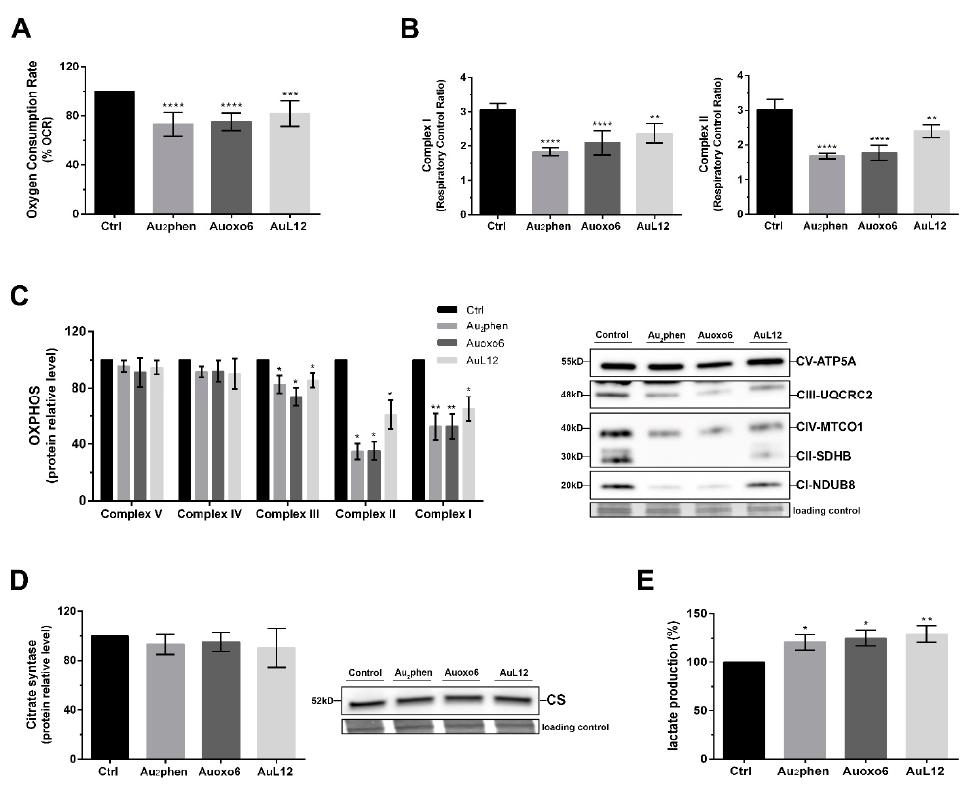
Figure 5. Influence of gold(III) complexes on mitochondrial metabolism. A2780 cells were treated for 24 h with Au 2 phen, Auoxo6, and AuL12 72 h IC 50 doses: ( A ) The percentage of oxygen consumption rate (OCR) and ( B ) the respiratory control ratio (RCR) values were measured using a Clark-type O 2 electrode from Hansatech Instruments (King’s Lynn, Norfolk, UK) as described in Materials and Methods. The protein amount of ( C ) oxidative phosphorylation (OXPHOS) complexes and ( D ) citrate synthase (CS) was evaluated using Western blot analysis. Histograms report the normalized mean relative integrated density (± SD) values for each OXPHOS complex, and CS immune-stained bands compared to controls. Representative immunoblots are also shown together with the matching Coomassie-stained PVDF membranes, which were used as loading control. Original Western blot images of OXPHOS and CS content are reported in Figure S4 and S5. ( E ) The lactate amounts were detected in 1 mL of supernatant medium using a commercial L-lactic acid assay kit (Megazyme, Bray, Ireland). Histograms report the percentages of mean values ±SD with respect to controls. All experiments were performed in triplicate. The statistical analysis was carried out using one-way ANOVA test followed by Tukey’s multiple comparisons test using GraphPad Prism software v 6.0 (* p < 0.05, ** p < 0.01, *** p < 0.001, **** p < 0.0001).